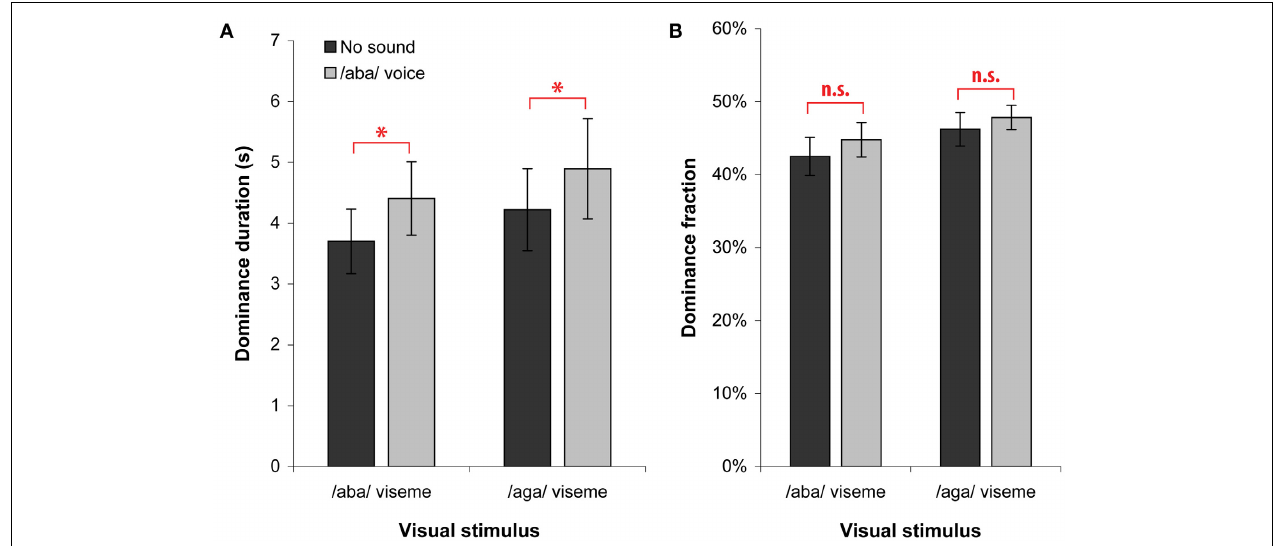
FIGURE 3 | Dominance duration (A) and fraction (B) when viewing passively. Dominances are plotted according to the perceived viseme (/aba/ and /aga/) for both the No sound condition (from Experiment B) and the /aba/ voice condition (from Experiment C). We found a